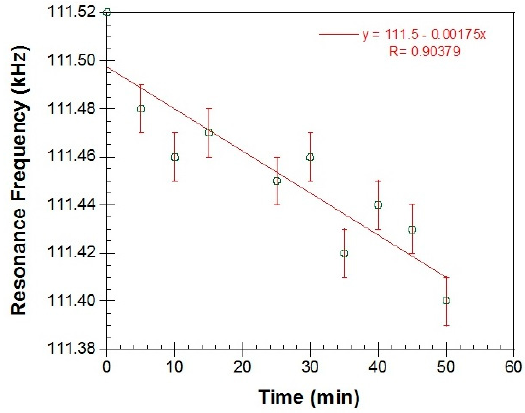
Figure 14. Magnetoelastic resonance data of a Metglas/ZnO/Hb electrode measured 5 min after the addition of increasing aliquots of H 2 O 2 .